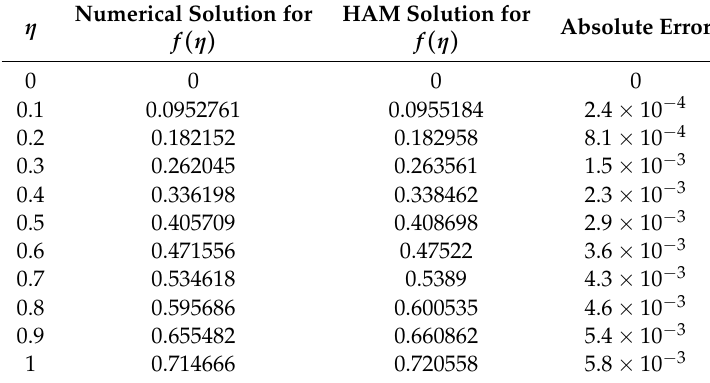
Table 2. HAM, Numerical Solution and their absolute Error are shown for f ( η ) , when h = − 0.47, λ = 0.2,kr = 0.2,Pr = 1,Ec = 0.6,Nb = 0.4,Nt = 0.5, S = 0.2, β = 1 and Sc =